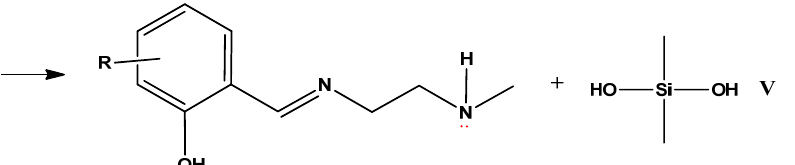
Scheme 11. The supposed mechanism for the cleavage of the AEAMDS amine in a reaction with carbonyl compounds.